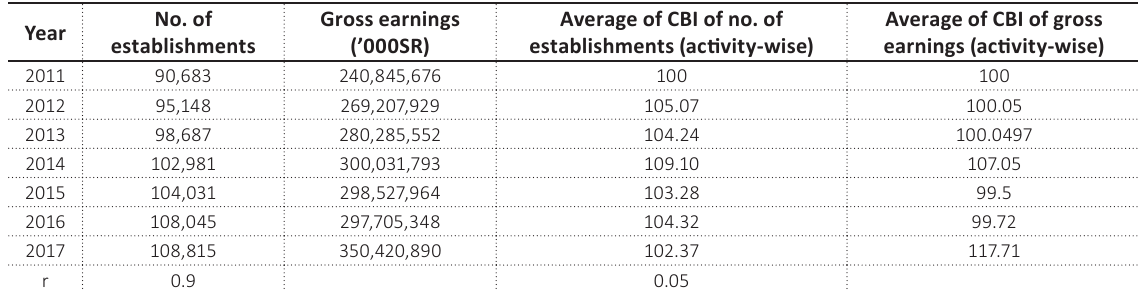
Table 2. Relationship (long-term and short-term) between the number of establishments and gross earnings